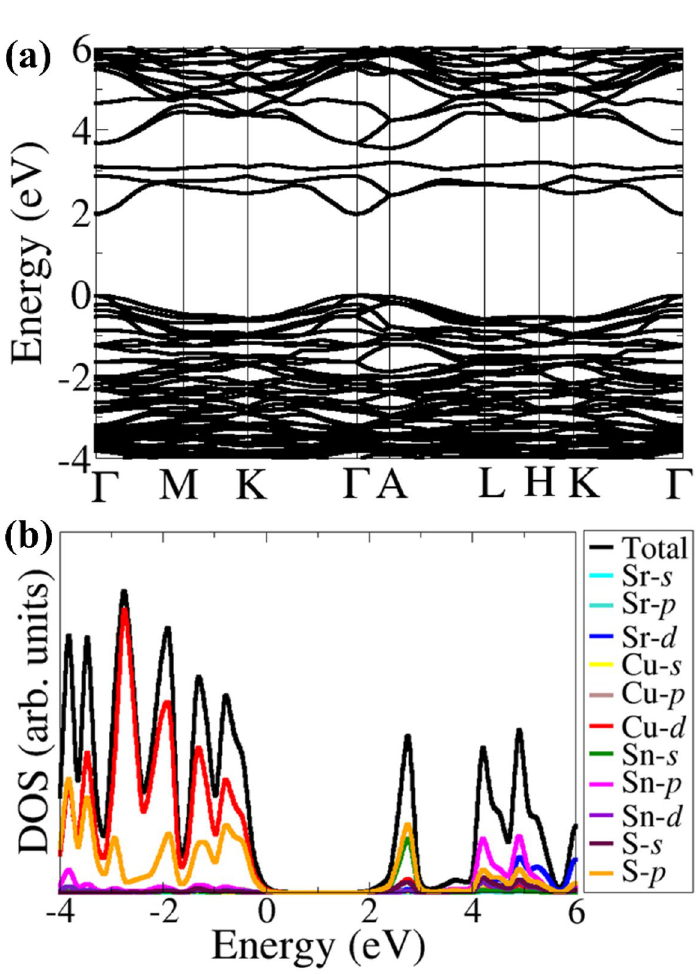
Figure 2. ( a ) band structure along the high-symmetry directions and ( b ) projected electronic density of states of Cu 2 SrSnS 4 obtained using HSE06